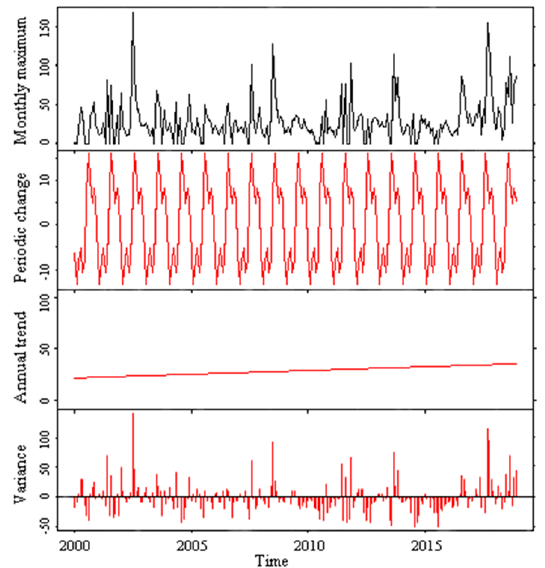
Figure 8. Variation in the monthly maximum values of the algal bloom area in Lake Dianchi for 2000-2018.